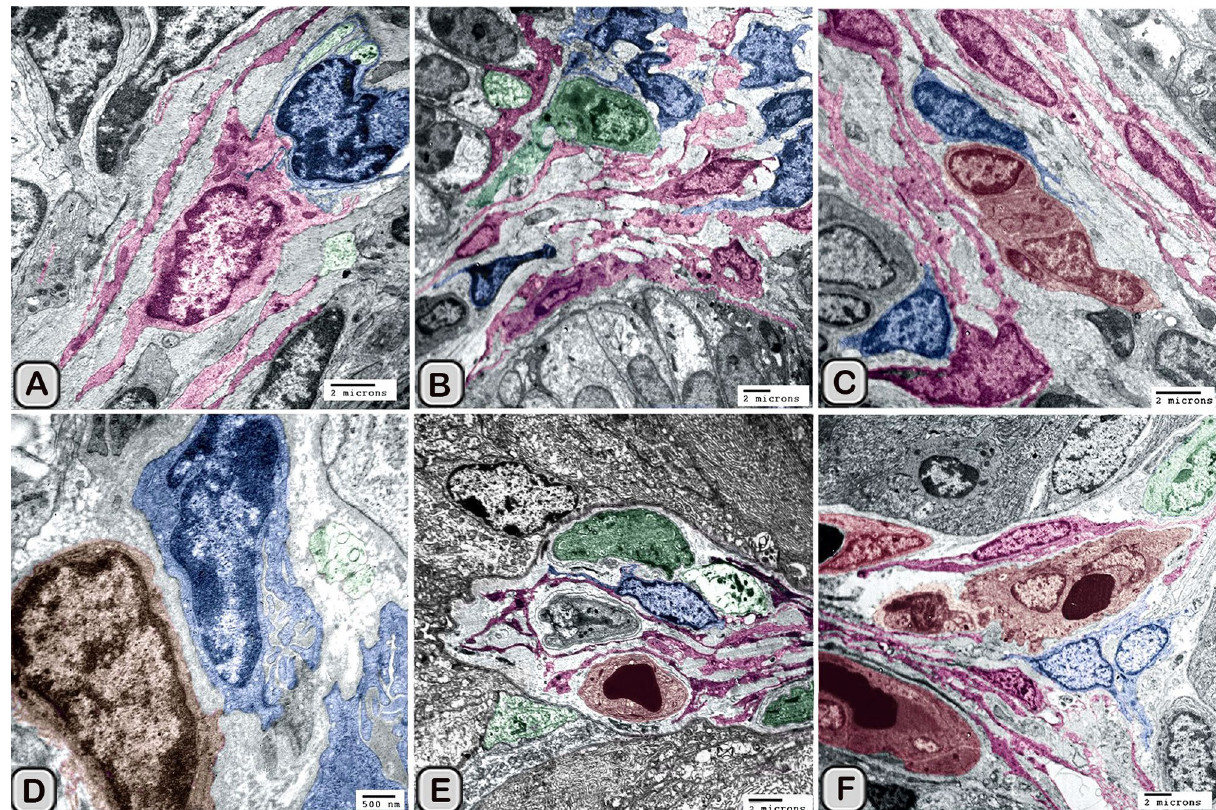
Figure 16. Digitally colored transmission electron microscope images of the Interstitial DCs in the control (A–C) and melatonin treated groups (D–F) . DCs process (blue) form hetercellular junctions with telocytes and its telopodes (pink). In addition, DCs were observed in a close contact to T-Lymphocytes (brown), Schwann cell, nerve fibers (green) and blood vessels (reddish